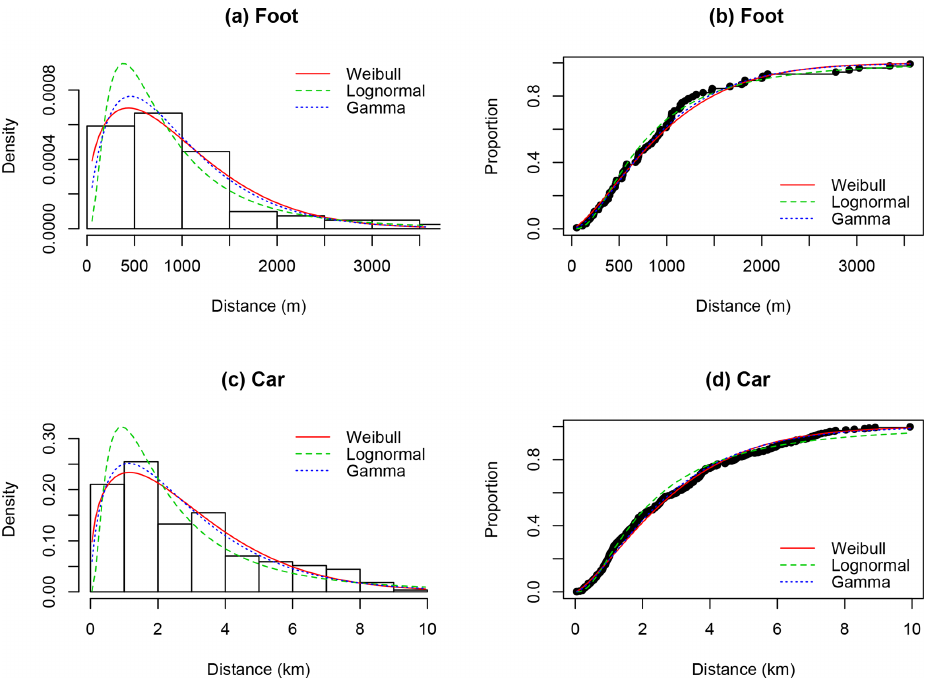
Figure 3. Intended evacuation destination from survey data and fitted models. Panels (a) and (c) are probability density functions; panels (b) and (d) are cumulative distribution